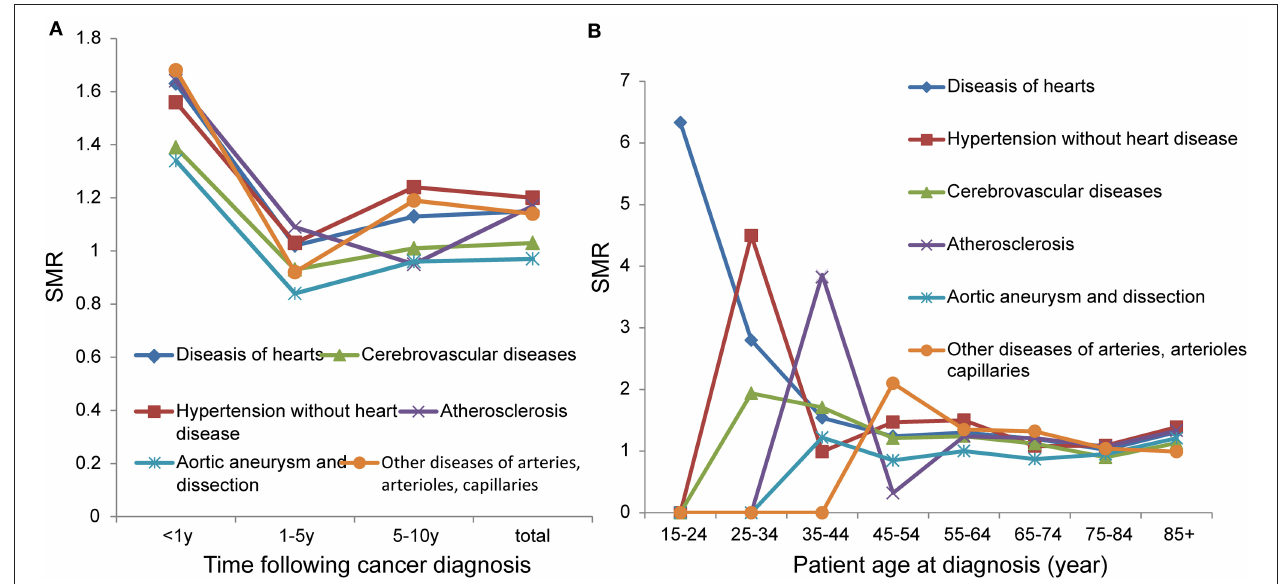
FIGURE 2 | SMRs of cardiovascular disease at different latency periods (A) ; SMRs of cardiovascular disease at different age (B)